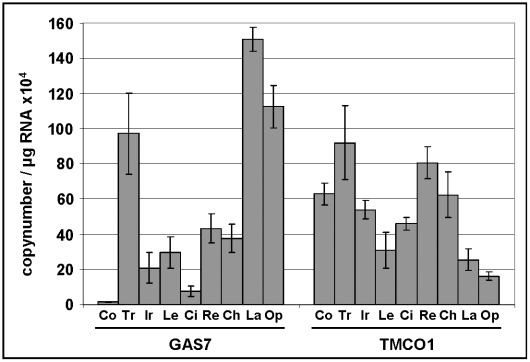
Expression levels of GAS7 and TMCO1 in human ocular tissues.Quantitative determination of GAS7 and TMCO1 mRNA expression levels in human ocular tissues by using real-time PCR technology (n = 4). The expression levels were normalized against GAPDH and the results are expressed as copynumber/µg RNA. Co, cornea; Tr, trabecular meshwork; Ir, iris; Le, lens; Ci, ciliary body; Re, retina; Ch, choroid; La, lamina cribrosa; Op, optic nerve.